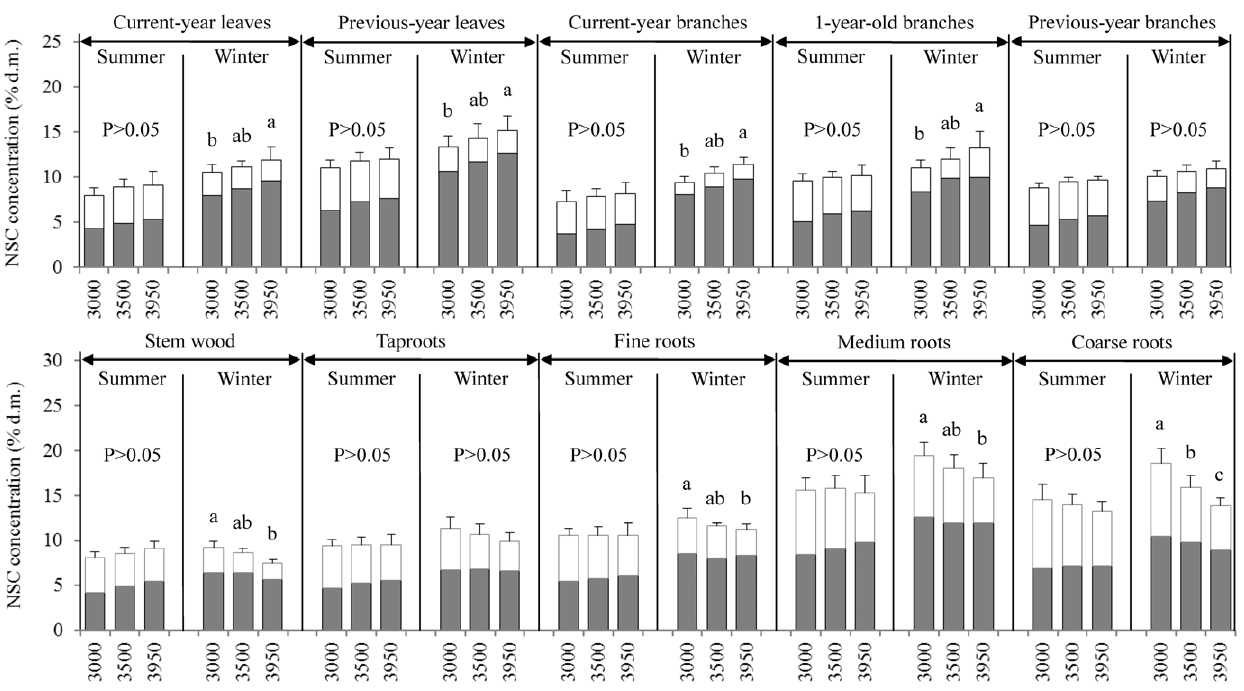
Figure 2. Mean concentrations of soluble sugars (dark gray), starch (white), and non-structural carbohydrates (NSC=soluble sugars + starch) in tissues of Quercusaquifolioides grown at 3000 m, 3500 m, and 3950 m a.s.l. during the growing season (May– September) and the dormant season (October–April), calculated using data measured across an one-year cycle from May 2008 to April 2009. Statistical differences in means among elevations within each tissue category and season were tested by t-paired comparison. Different letters indicate statistically significant differences (p , 0.05) in NSC among elevations. Standard error bars ( + 1SE) are given for NSC only.